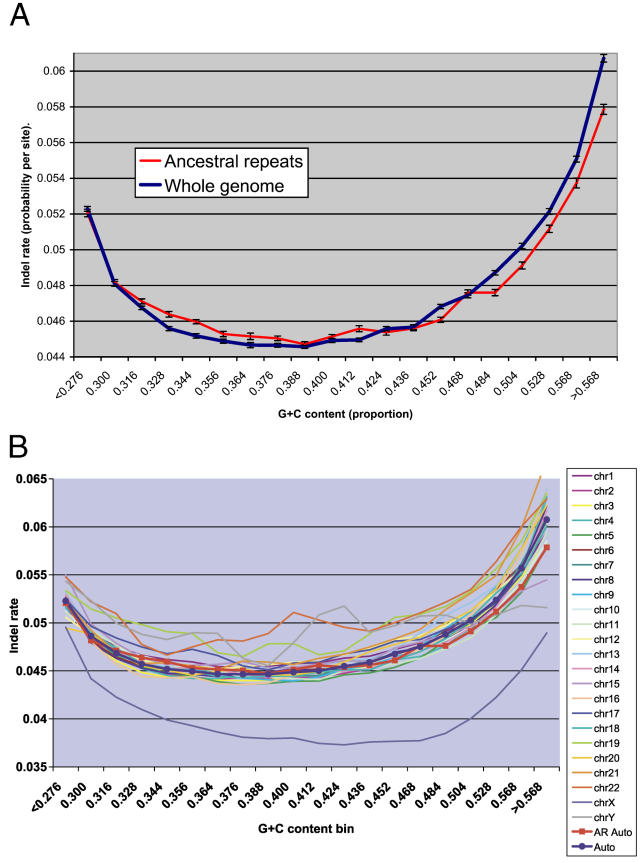
Indel Rate Variation by G+C Content(A) Whole genome (blue) and AR (red) averages of indel rates. Error bars denote 95% confidence intervals in ρ as determined by weighted linear regression on log frequencies in the intergap length histogram.(B) Indel rates per G+C content for individual chromosomes (error bars not included for clarity), and autosomal averages (whole autosome, blue; ARs, red). Most autosomes have undergone similar indel rates, with mildly increased rates for the small chromosomes (22 and 19 in particular), and a marked reduction for X, as expected by its distinct germline history. Because of its size, measurements on the Y chromosome lack accuracy, but are consistent with an increase in indel rates.